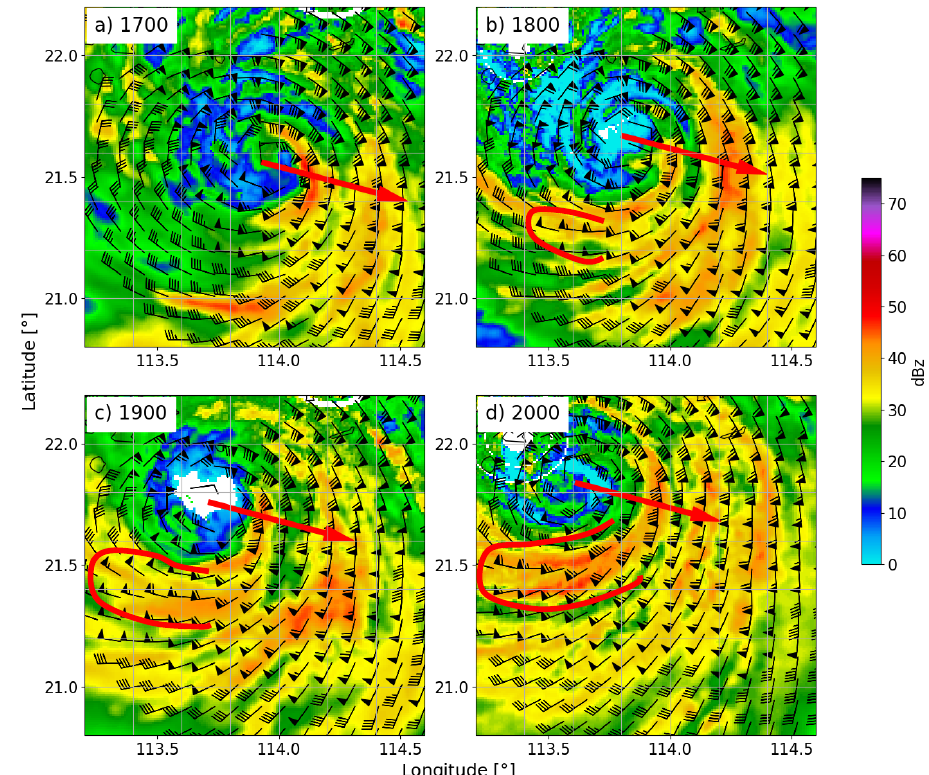
Figure 8. The horizontal winds at 4 km altitude in the inner-core area of Typhoon Higos retrieved by Zhuhai–Macao radar, HK Tate’s Cairn radar and Shenzhen radar at ( a ) 17:00, ( b ) 18:00, ( c ) 19:00 and ( d ) 20:00 UTC on 18 August 2020. In the figure, the 4 km altitude reflectivity at the four moments are superimposed. Red arrows represent the VWS vector of 200–850 hPa. The black triangles in the wind barbs represent the wind speed at 20 m/s, the long rods represent 4 m/s and the short rods 2 m/s.